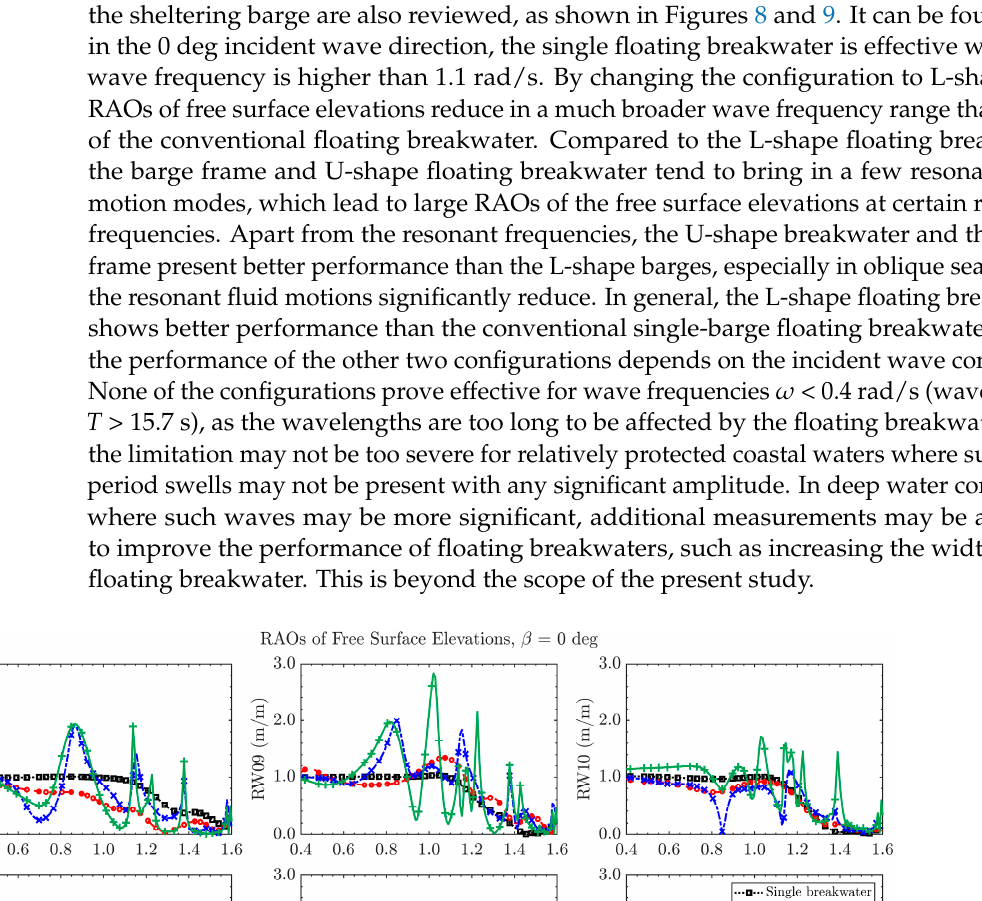
Table 3. Cancellation frequencies identified from the motion RAOs of the barge frame in 0 deg incident wave direction.